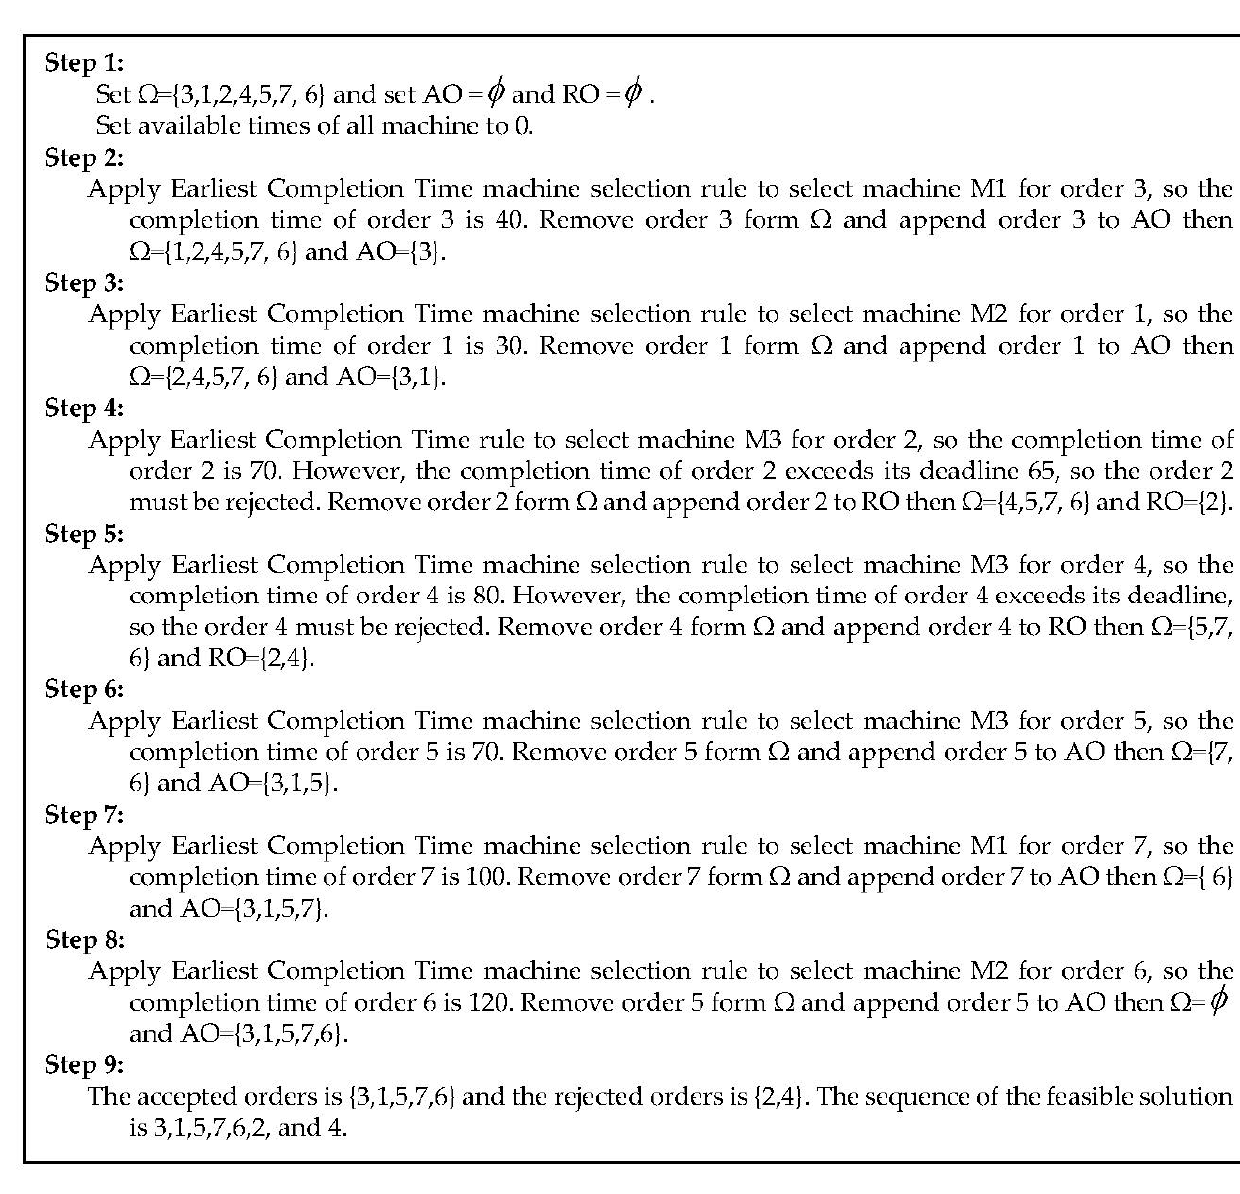
Figure 3. The work of scheduling for OAS problem.